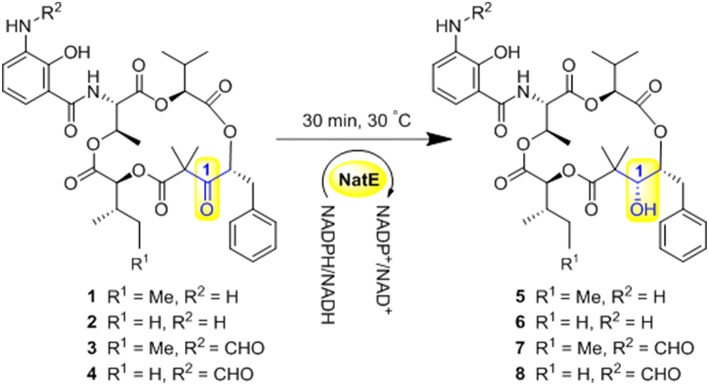
Ketoreductase NatE catalyze the reduction of 1–4 to generate 5–8.